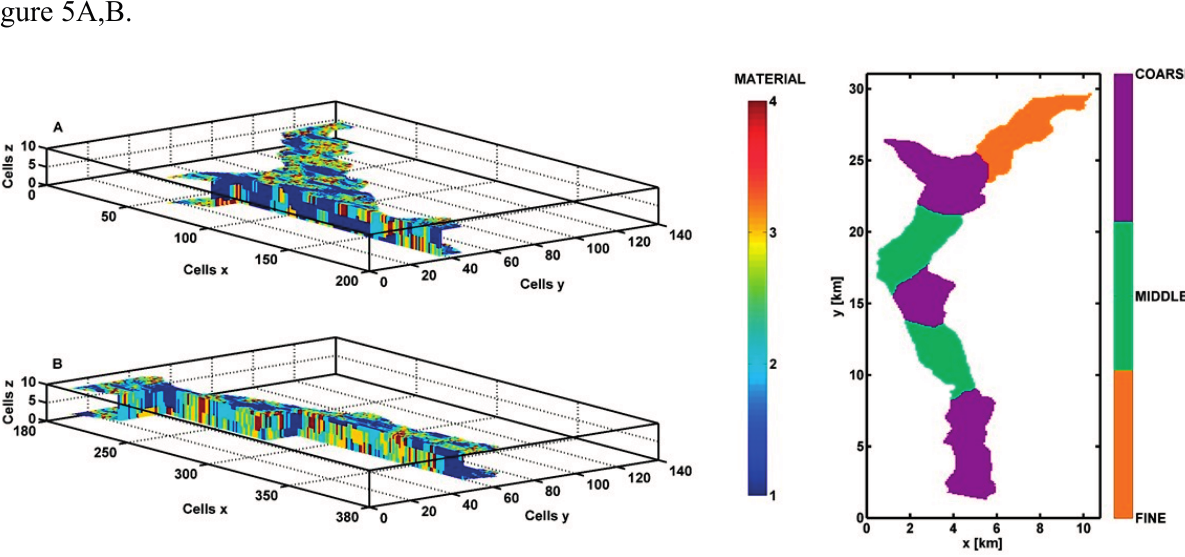
Figure 5. Example of the generated hydraulic conductivity fields ( A to B ); zonation for the hydraulic conductivity values ( C